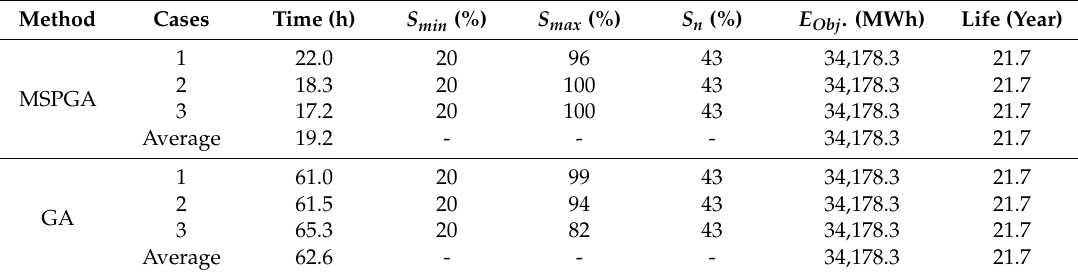
Table 9. Comparison of calculation time and results between PGA and